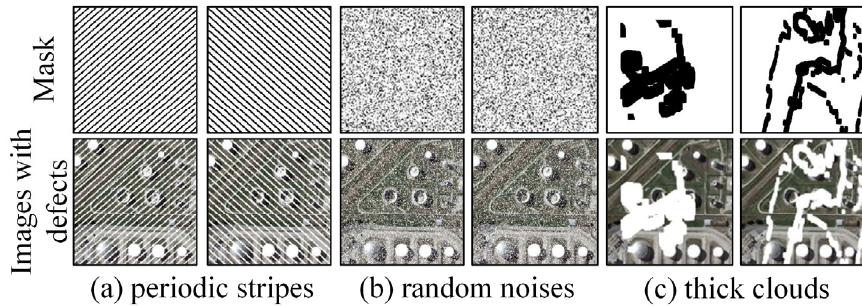
Figure 7. Example images of 3 masks dataset. The first row is the mask image, and the second row